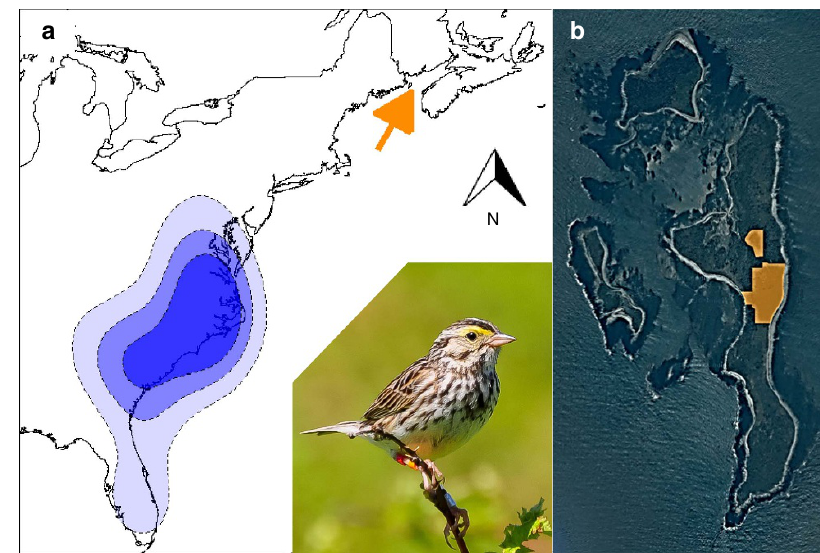
Figure 1 | Winter distribution and breeding ground study site of Savannah sparrows from Kent Island. ( a ) Winter distribution (blue contours) of Savannah sparrows from a breeding population on Kent Island, NB, Canada (orange arrow) inferred from geolocator tracking data collected from 2011 to 2014. Blue contours delineate the 30, 50 and 75% kernel densities estimated from the winter locations of 38 individuals. Embedded photo shows a colour-banded Savannah sparrow (photo courtesy of S. Doucet). ( b ) Long-term study area (orange) on Kent Island, with Sheep Island to the west and Hay Island to the north (north arrow in a also applies to b